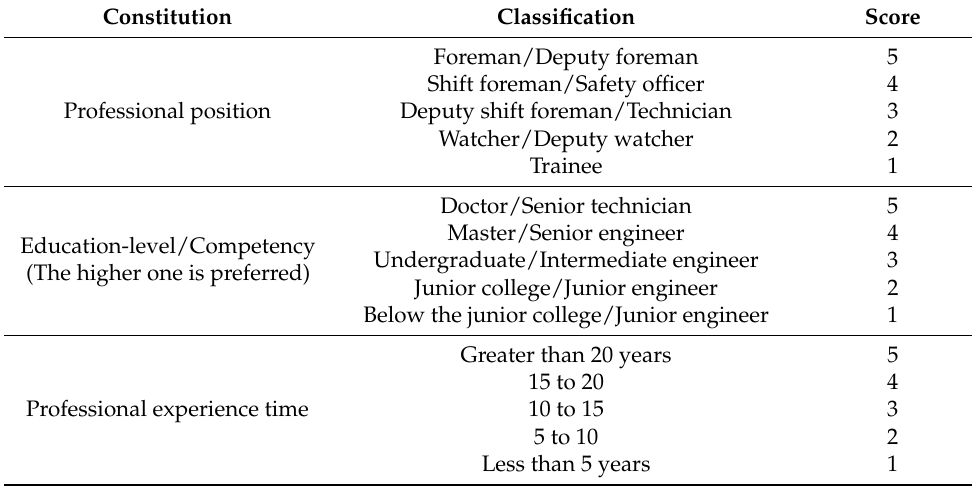
Table 1. Expert’s weighting